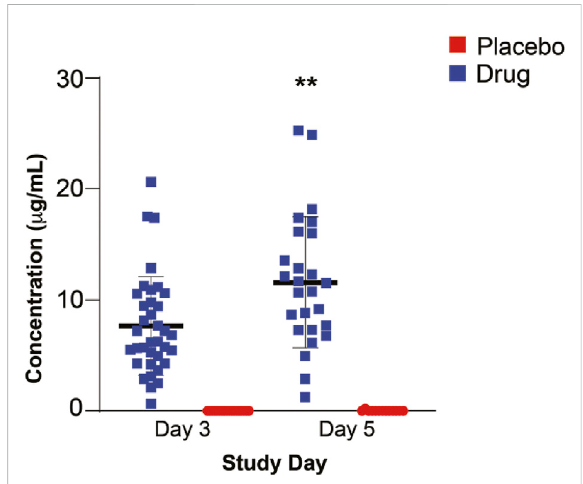
FIGURE 2 Atovaquone Plasma Concentration. Atovaquone plasma concentration measured at day 3 and 5 following initiation of therapy. Day 3 drug levels were signi fi cantly lower than those of day 5. (** p < 0.005).